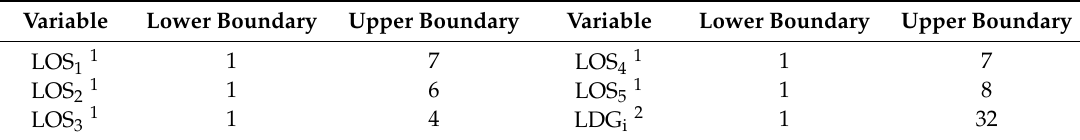
Table 4 lists the boundaries of the location-optimization variable values. Table 4. Boundaries of location-optimization variable